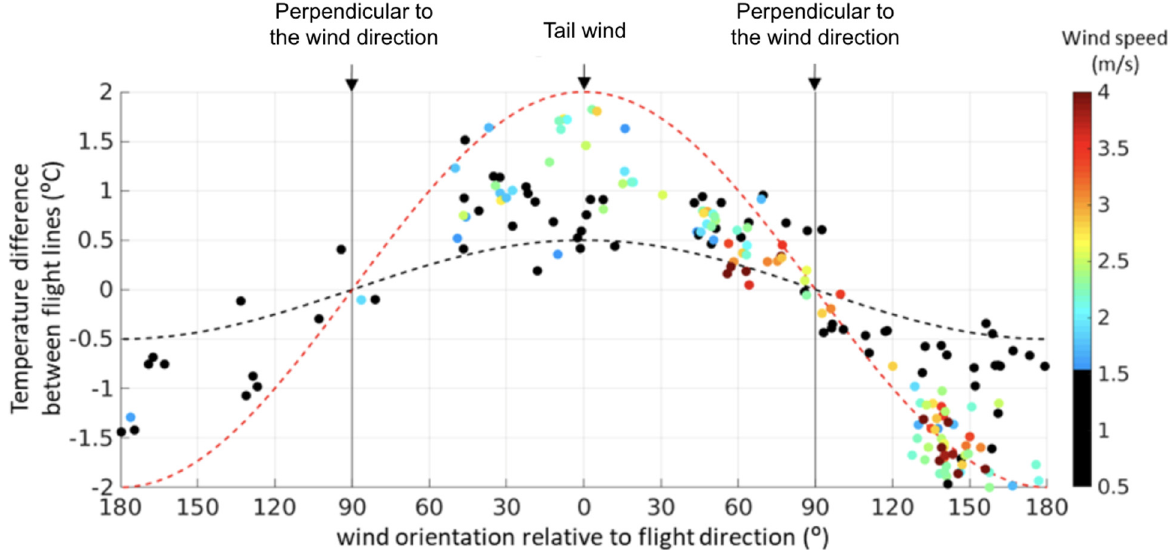
Figure 8. Scatterplot of difference in temperature between inbound and outbound orthophotos caused by the wind direction relative to the UAV flight direction for the four, five and three flight surveys on 9 November, 20 December and 7 January, respectively (N = 183). The wind speed at the acquisition time is represented by the color bar from 0 to 4 m/s. Dashed lines represent upper and lower bounds with a maximum of 2 and 0.5 °C for high and low wind speeds, respectively, and were inserted to facilitate the interpretation of the figure.